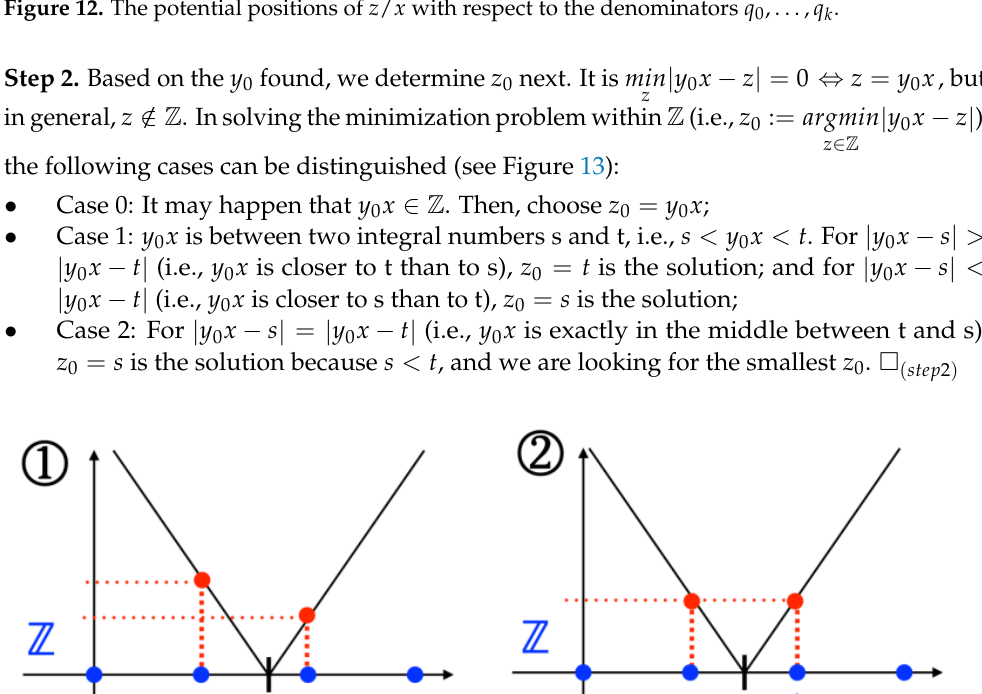
Figure 13. The potential positions of 𝑦 (cid:2868) 𝑥 .